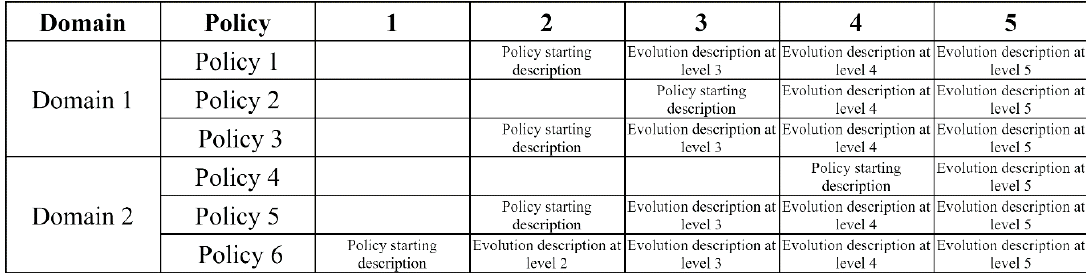
Figure 1. Graphical overview of resulting progression models.